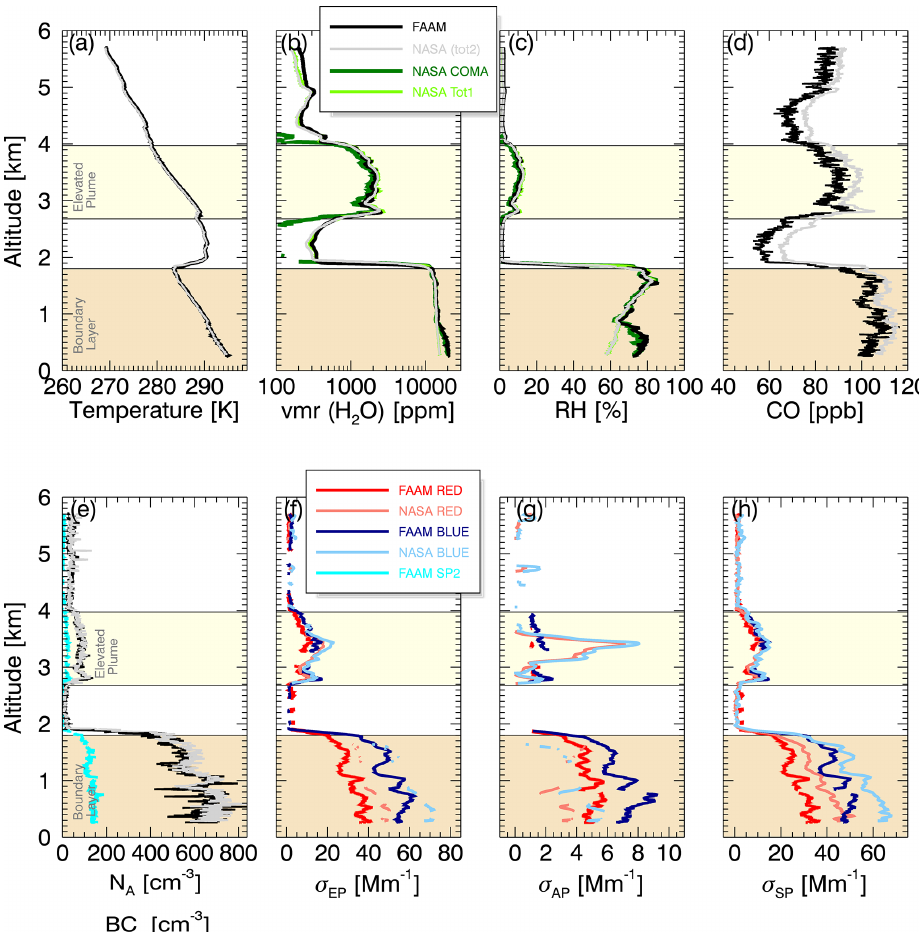
Figure 4. Vertical profiles of data from FAAM BAe-146 and NASA P3 for intercomparison “runPRO” descent from 5.8km to 300m. Horizontal bands mark out the vertically elevated pollution plume (yellow) and boundary layer (light orange). (a) Temperature; (b) water vapour mixing ratio; (c) RH; (d) CO; (e) N A from PCASP, with BC n from FAAM SP2; (f) optical extinction, σ EP , from FAAM CRDS and NASA PSAP + nephelometer; (g) optical absorption, σ AP , from FAAM PAS and NASA PSAP; (h) optical scattering, σ SP , from FAAM CRDS-PAS and NASA nephelometer. The legend in panel (b) applies to panels (a)–(e) . The legend in panel (f) applies only to panels (f)– (h) for wavelengths of 470nm (blue) and 660nm